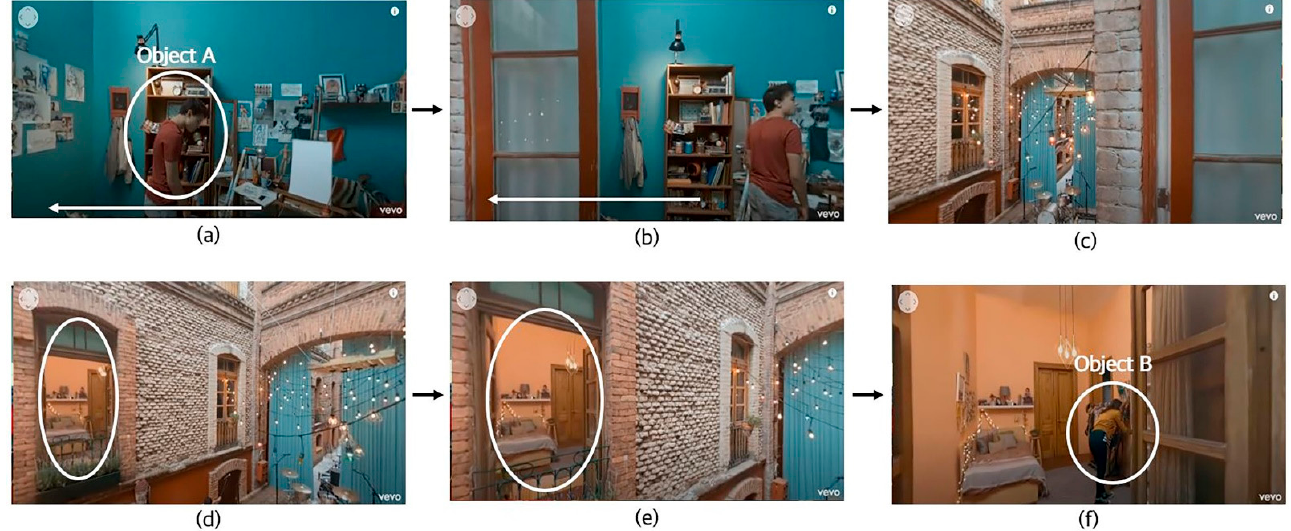
Figure 7. Directed Case 2 using “Camera movement” (video No. 14). ( a,b ) The camera moves to the left in the direction of the arrow from the space where object A plays, ( c ) The user moves their attention in the direction where the camera moves, ( d ) The user can see the marked space, ( e ) The camera continues to move toward the marked space, ( f ) The user can see the scene where object B plays, in the position intended by the director.